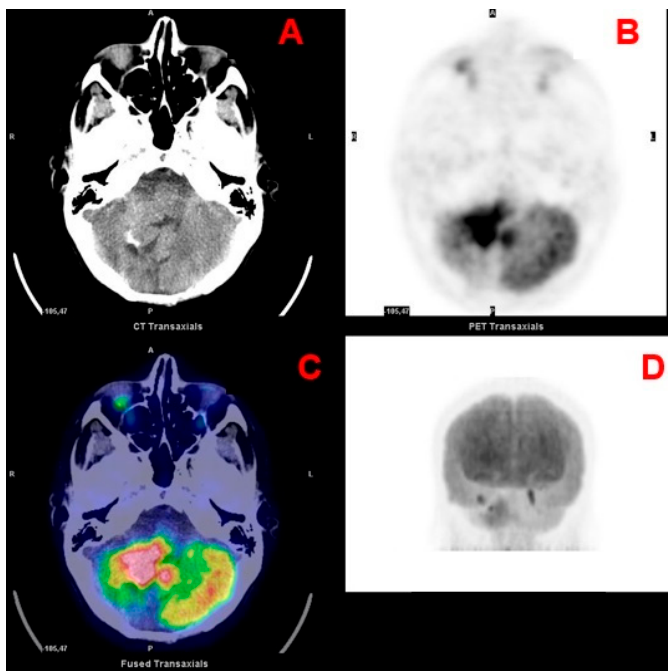
Figure 1. Transaxial CT ( A ), PET ( B ) and fused PET/CT ( C ) and maximum intensity projection ( D ) images of a medulloblastoma.